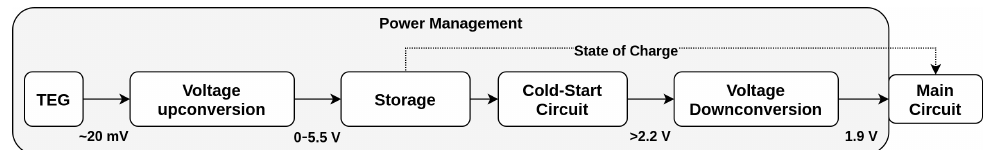
Figure 4. Concept of the power management circuit: The output voltage of the TEG is first upcon- verted and stored in a capacitor. A cold start circuit disconnects the rest of the system if the voltage falls below a threshold. Otherwise, the capacitor voltage is stabilized to the constant output voltage needed to drive the attached